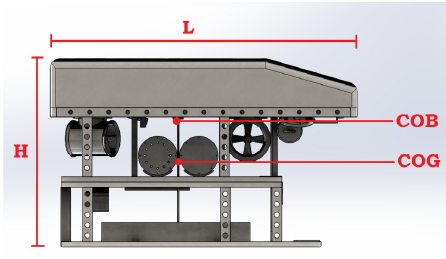
Figure 5. Underwater Robot Sf ‐ 30k.